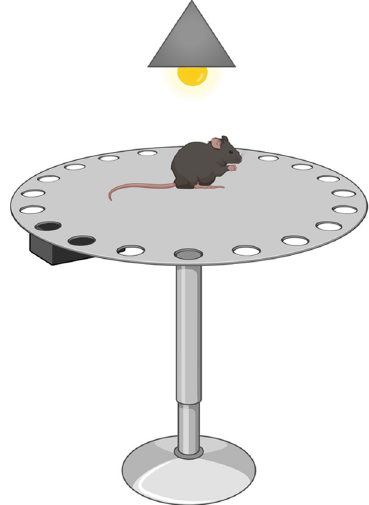
Figure 8. Barnes maze. The animal is first positioned in the center of the apparatus and then allowed to explore the various orifices upon exposure to aversive stimuli, such as lights and sounds. The time it takes to find the exit leading to the refuge box is evaluated.